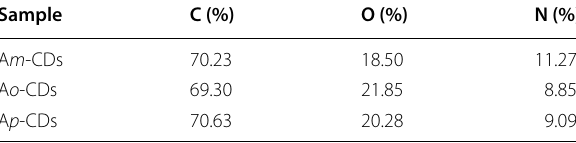
interaction between highly polar solvent and CDs, and (3) water-induced morphological change [25].